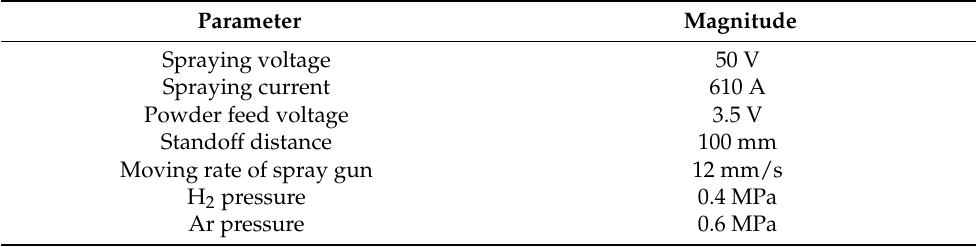
Table 2. Spraying parameters of the plasma spraying